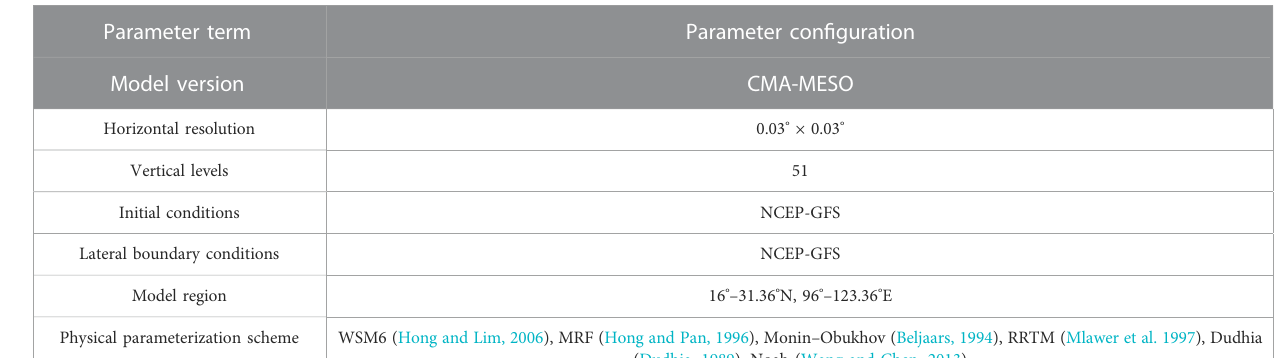
TABLE 1 Con fi guration of the